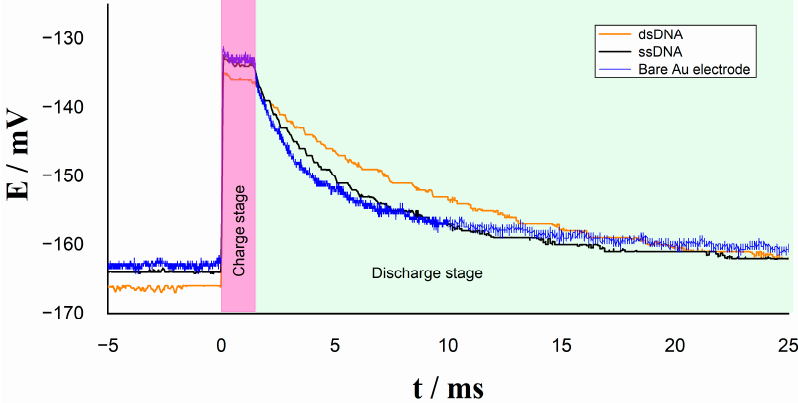
Figure 6. Relaxation voltage with external capacitor C out on different electrodes.